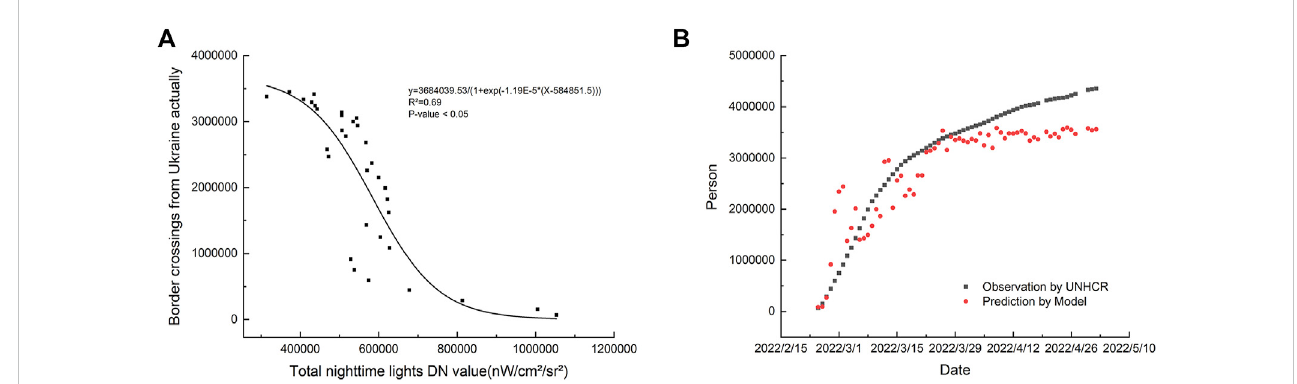
FIGURE 8 Relation between the refugee population and the total nighttime light DN value (A) ; validation of the model of migration and nighttime lights using the UNHCR data (B) .